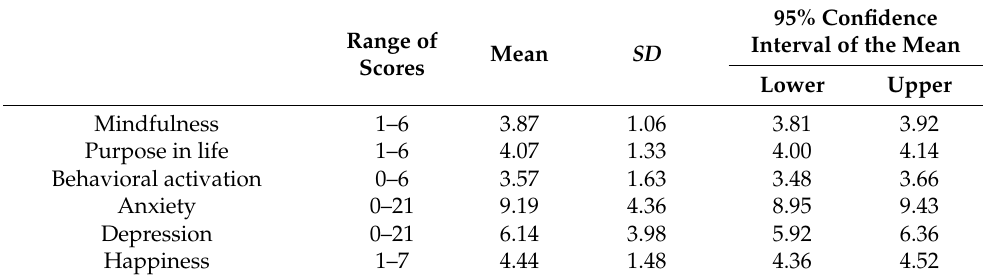
Table 1. Descriptive statistics for mindfulness, the proposed mediators (purpose in life and behavior activation), and outcome variables (anxiety, depression, and